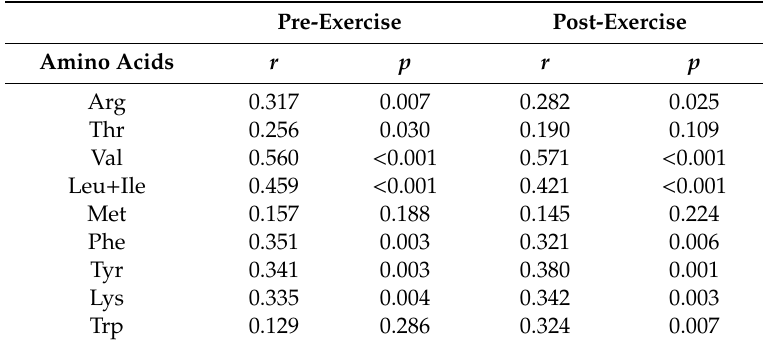
Table 5. Spearman correlation coe ffi cients ( r ) and p values of dietary intake and plasma concentrations of amino acids in the whole cohort. Pre-Exercise Post-Exercise Amino Acids r p r p Arg 0.317 0.007 0.282